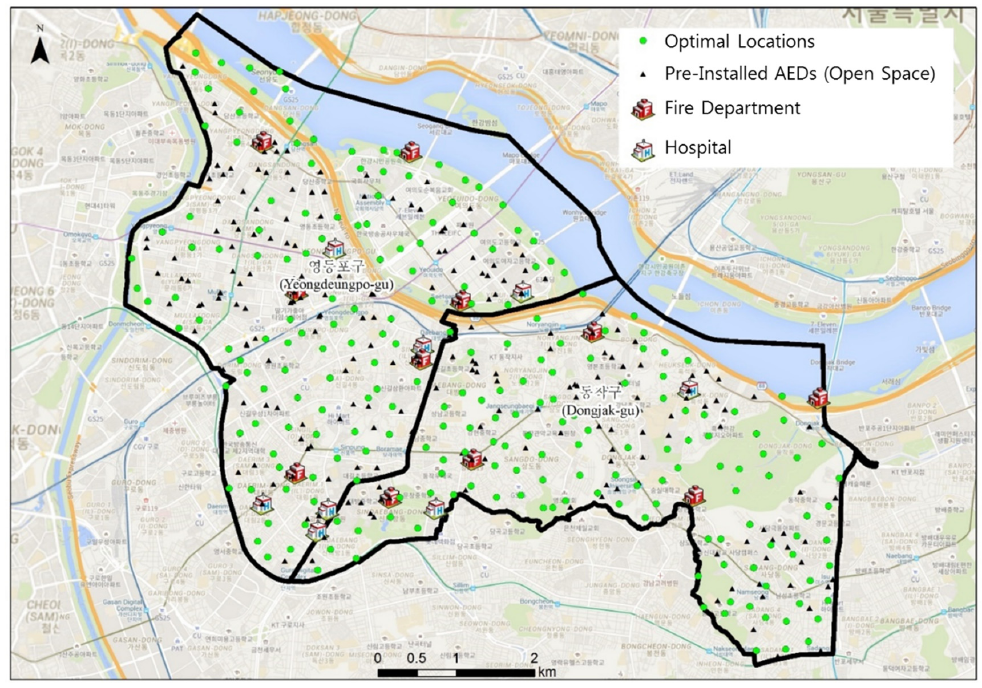
Figure 11. Optimal AED locations.